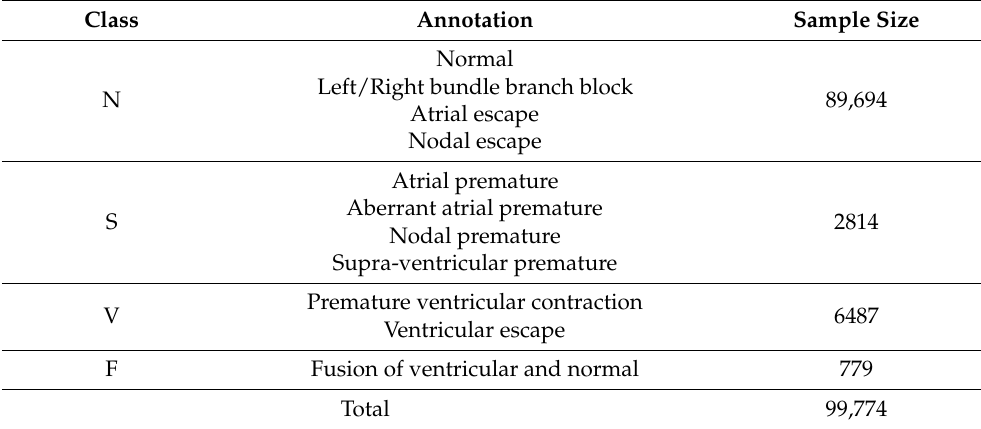
Table 1. Arrhythmia classes, related annotation and sample size of each class in the dataset.